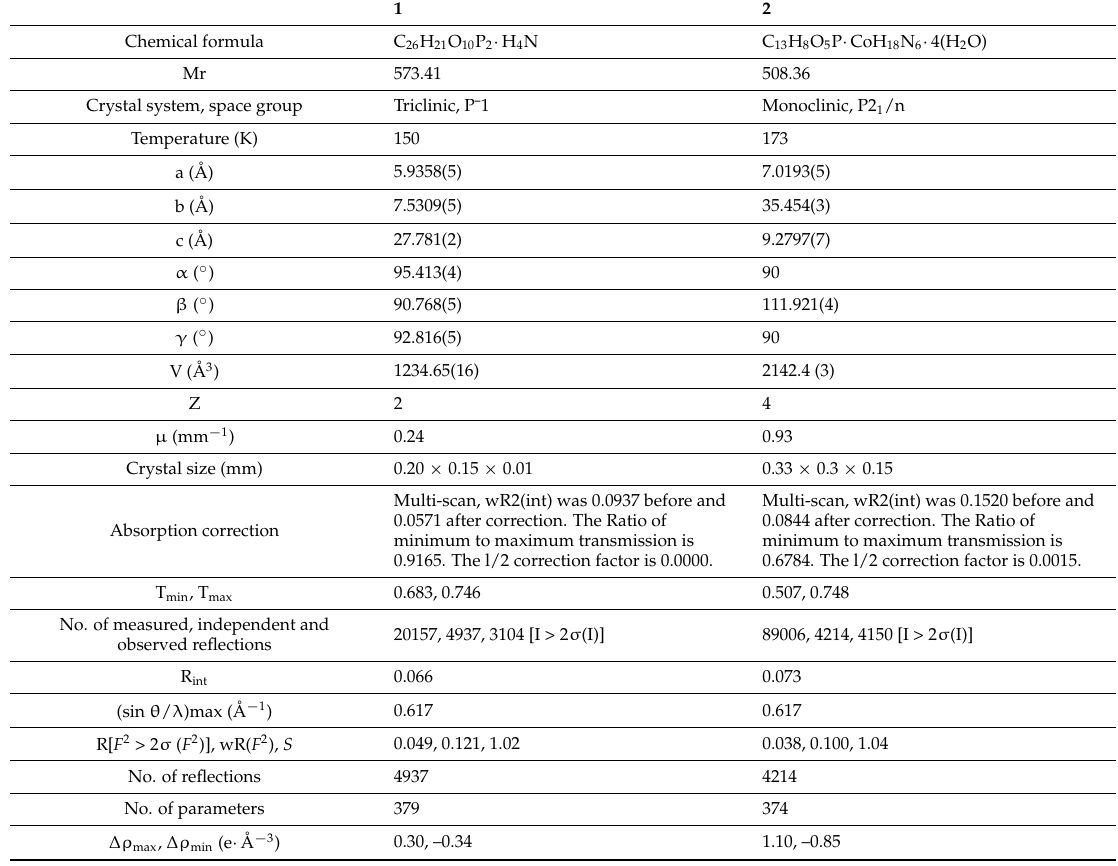
Table 5. Crystal data and refinement